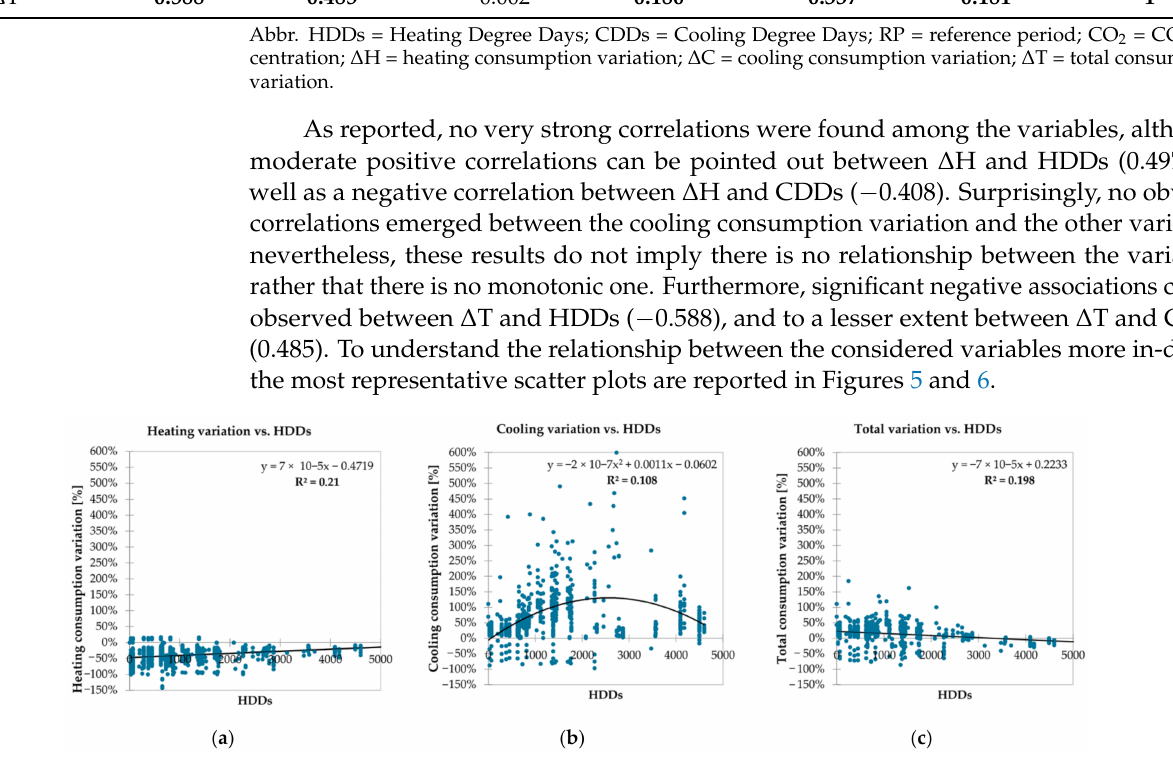
Figure 5. Relationship between HDDs and: ( a ) heating consumption variation; ( b ) cooling consump- tion variation; ( c ) total consumption